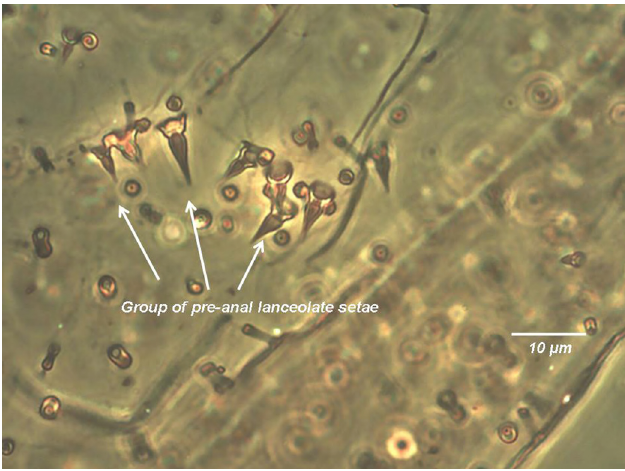
Figure 3. Nipaecoccus coffeae : group of pre-anal abdominal cerarium showing broadly lanceolate setae.